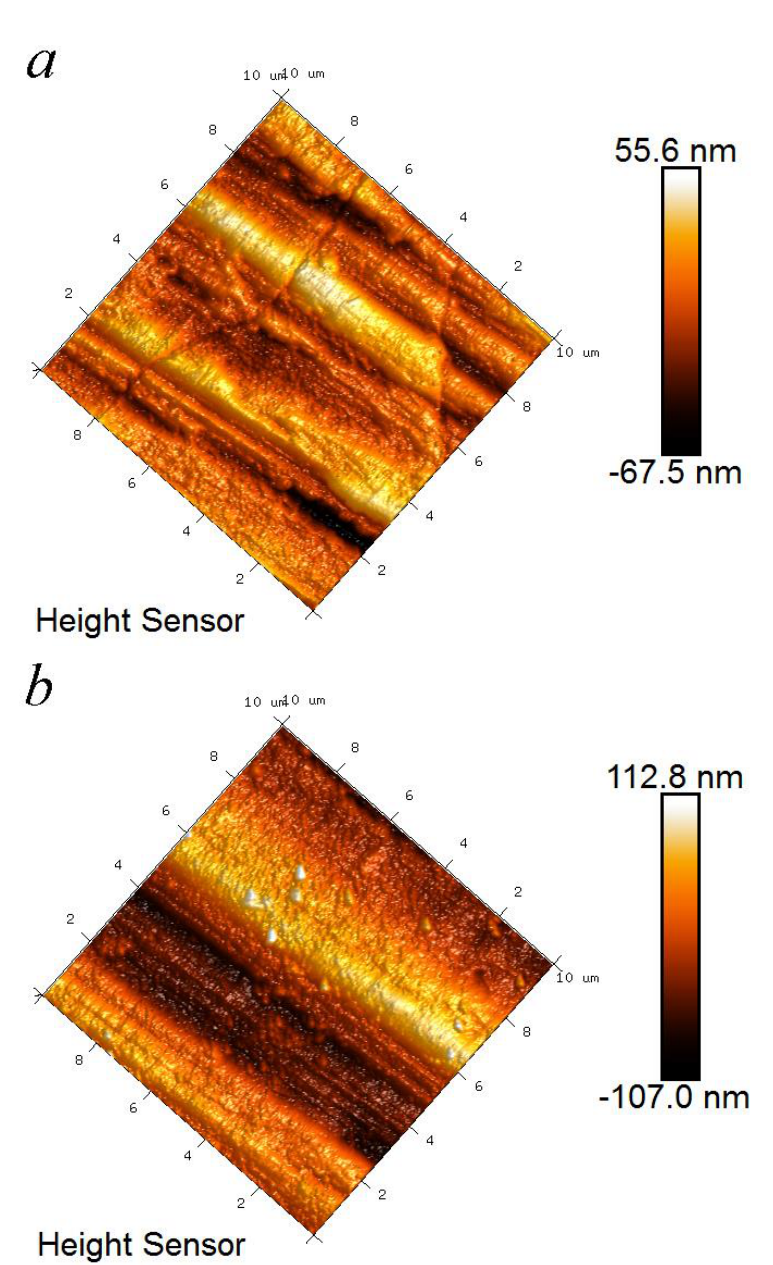
Figure 4. Surface topography by atomic force microscope (AFM) and surface roughness: ( a ) TC4; ( b ) TLM.